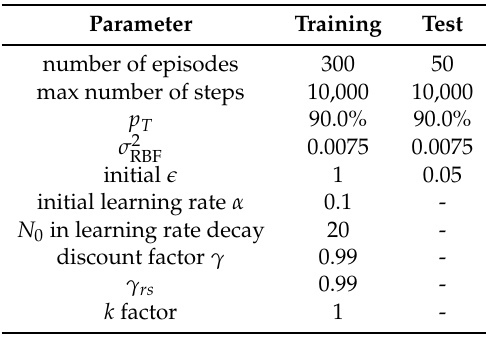
Table 2. Parameters used in FERMI free electron laser (FEL) Q-learning.